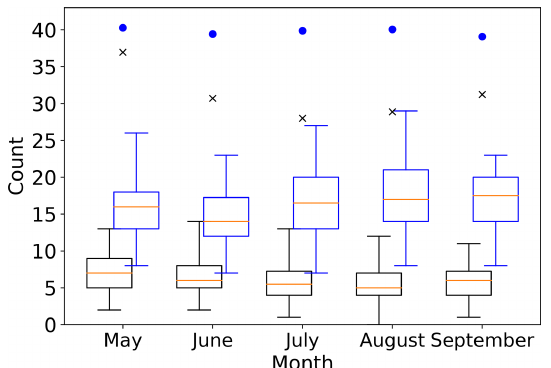
Figure 8. Box and whisker plot of the monthly counts of the matched (black) and unmatched (blue) cyclones. The median values for the 40-year dataset are given by the orange bars in the boxes, and the boxes span the interquartile range. The whiskers extend to show the full range of the data. The box and whiskers for the matched and unmatched cyclones are slightly offset for clarity. Also shown are the mean monthly numbers of TPVs with Arctic genesis (black crosses) and Arctic cyclones with maximum intensity in the Arctic (blue circles). All data are for systems with lifetimes ≥